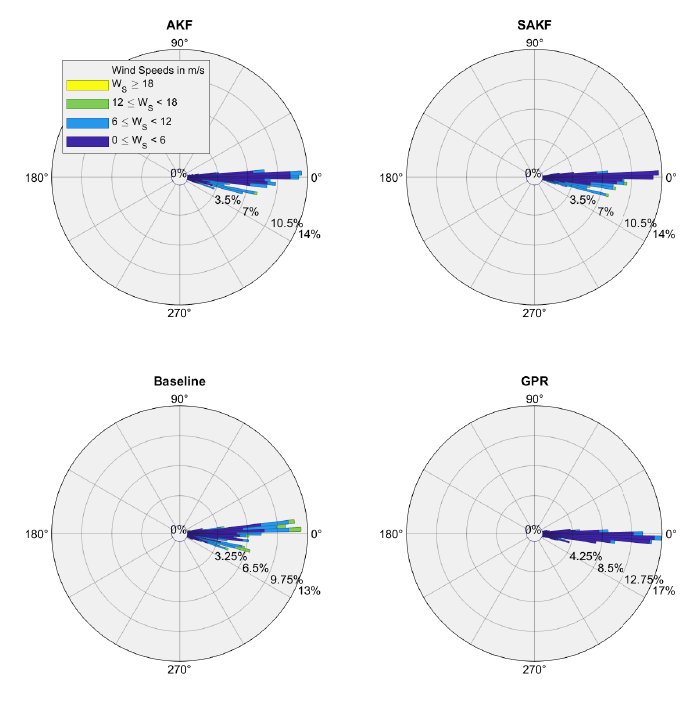
Figure 6. Rose diagrams of the wind direction estimation errors for the different